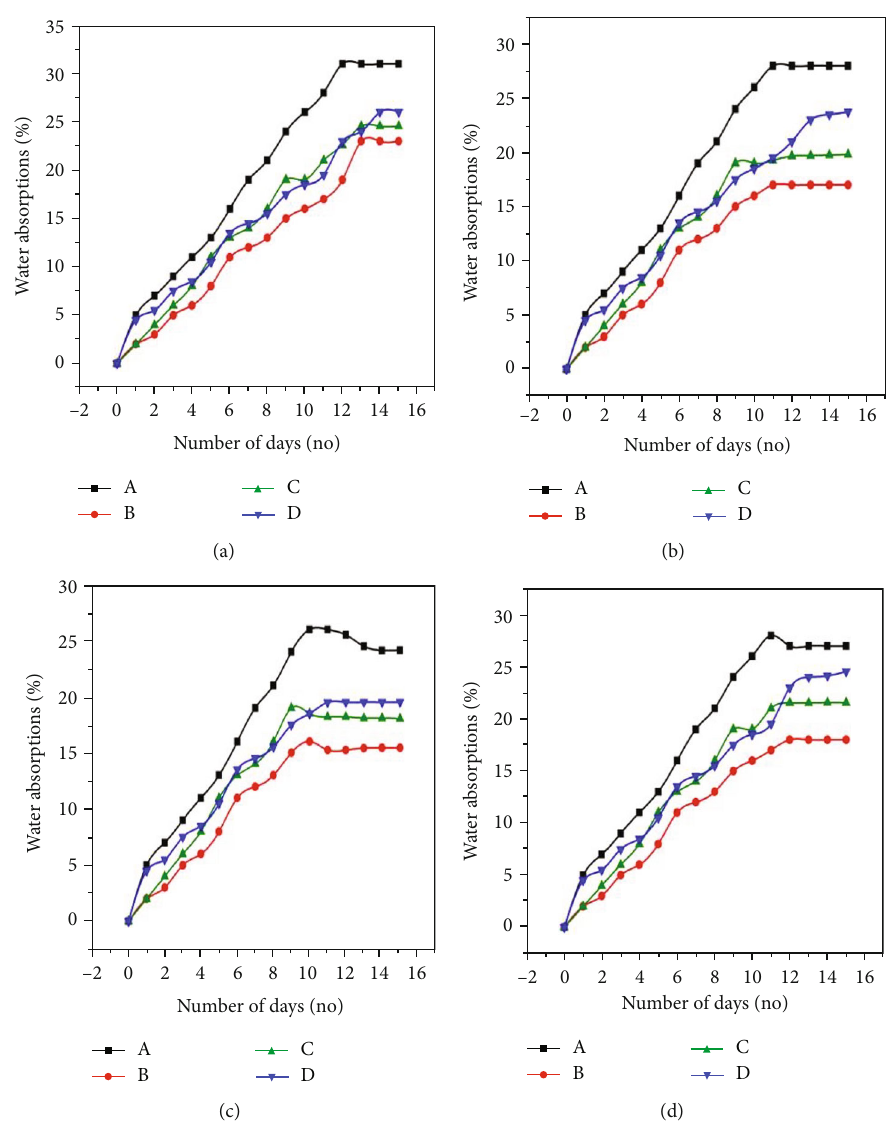
Figure 10: Hygroscopic behavior: (a) 0 wt.% of silica, (b) 3 wt.% pf silica; (c) 6 wt.% of silica, and (d) 9 wt.% of